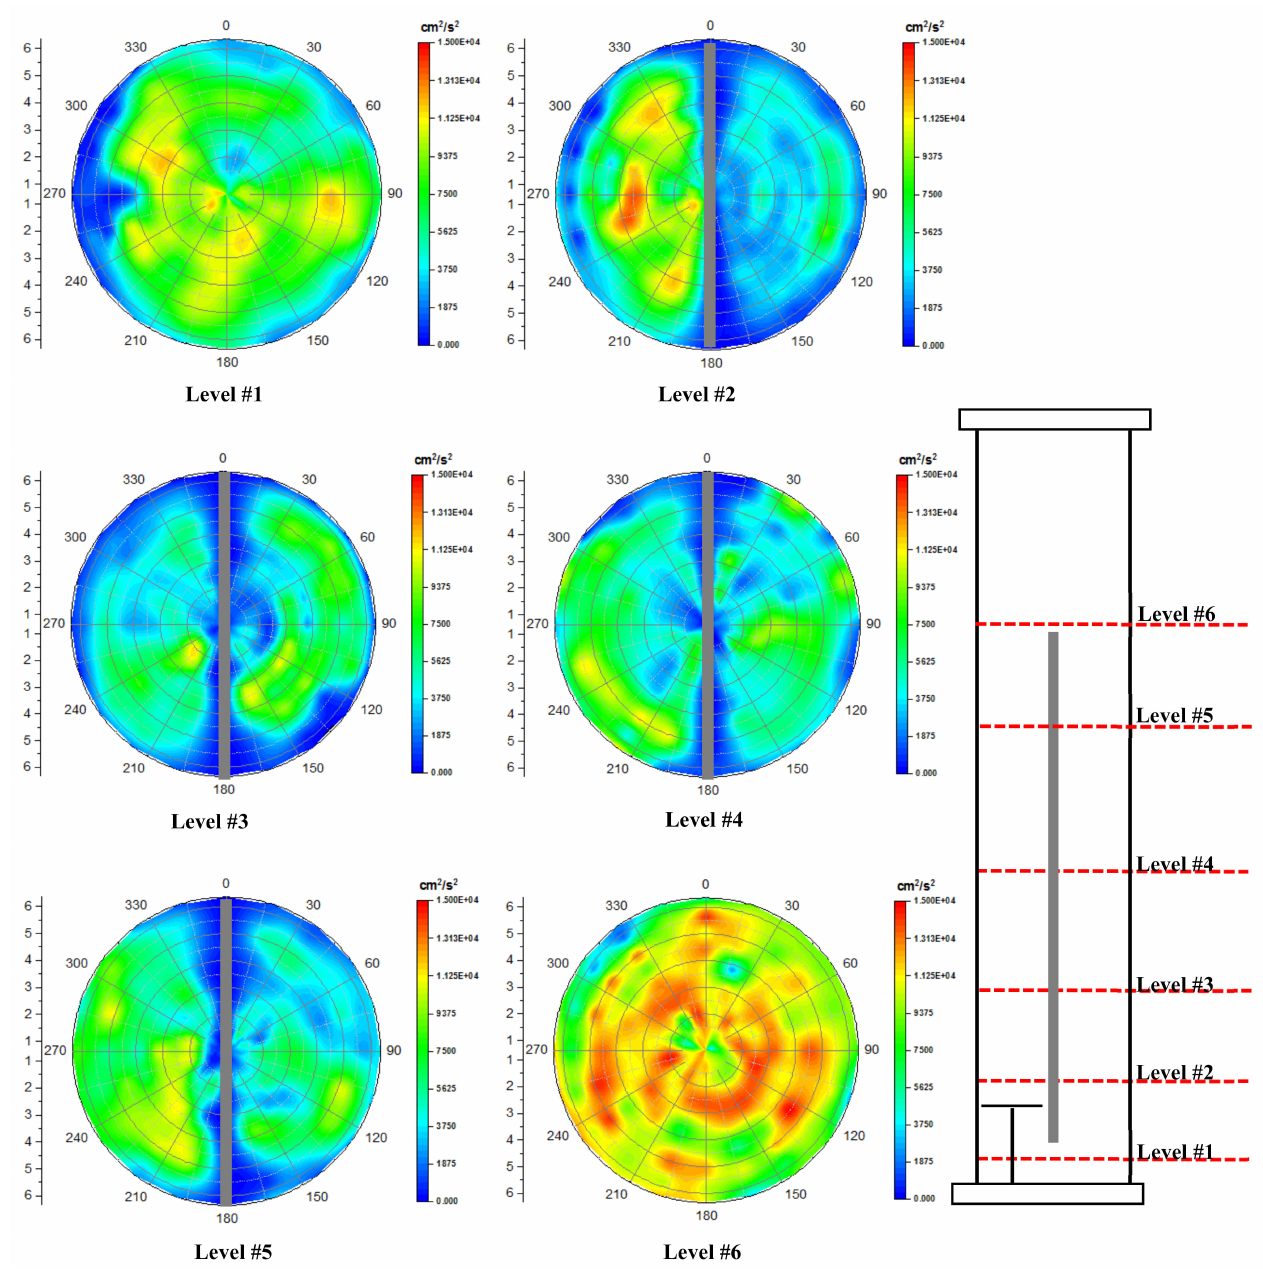
Figure 21. Cross-sectional distributions of turbulent kinetic energy at different heights of split airlift reactor operated under gas velocity of 2